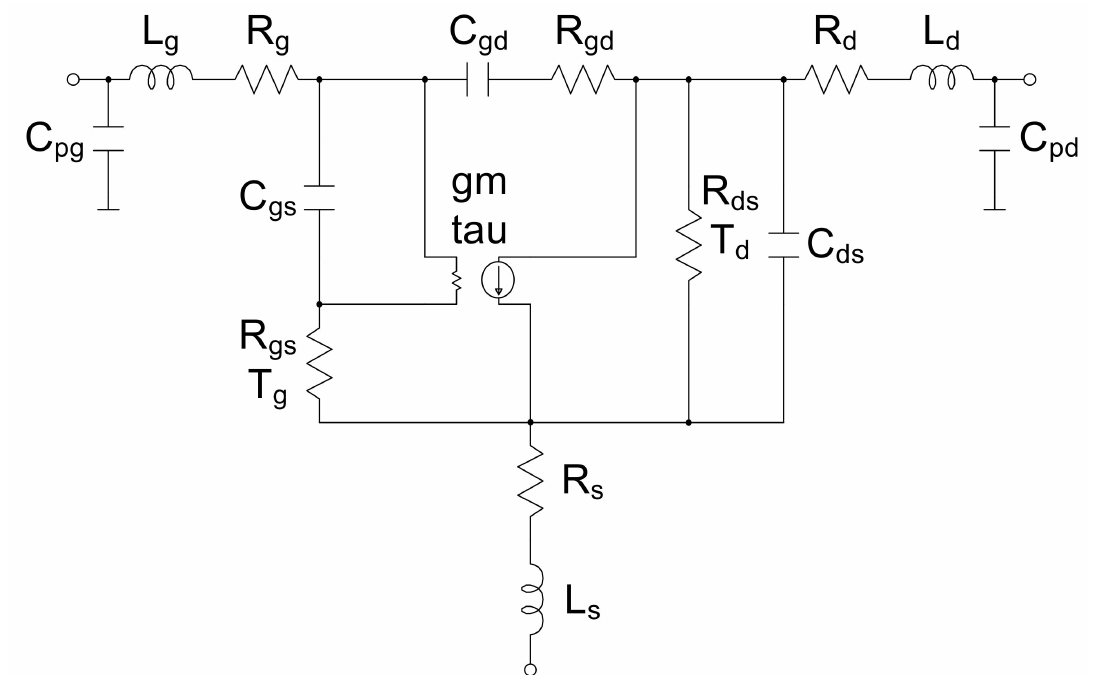
Figure 4. Small-signal equivalent circuit for the simulation of GaAs